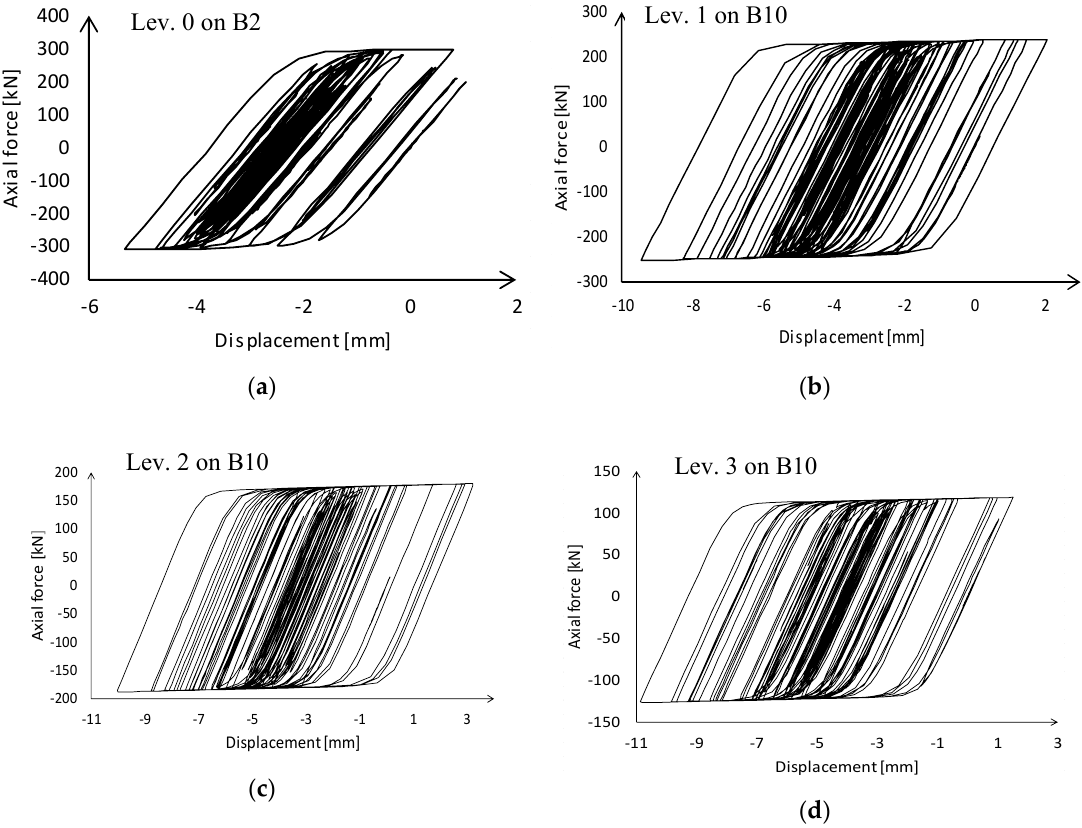
Figure 10. Cyclic response of different Buckling-Restrained Axial Damper (BRAD) types under an accelerogram of the Maximum Considered Earthquake (MCE): ( a ) 34/30-b ( b ) 27/30-b ( c ) 21/30-b ( d ) 14/30-b.